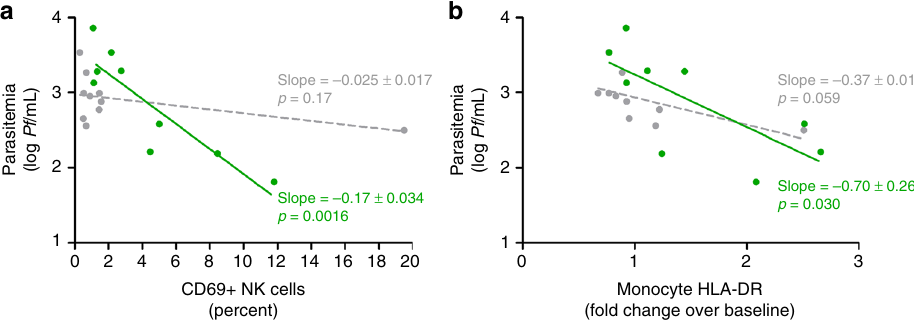
Fig. 3 Early NK cell and monocyte activation correlates with decreased parasitemia. Correlations between a NK cell CD69 expression and log parasitemia on day 7 after challenge infection, and b increase in monocyte HLA-DR MFI and log parasitemia on day 7 are shown for BCG vaccinated ( n = 9, green) and control ( n = 10, grey) volunteers. Lines show the result of linear regression analysis for